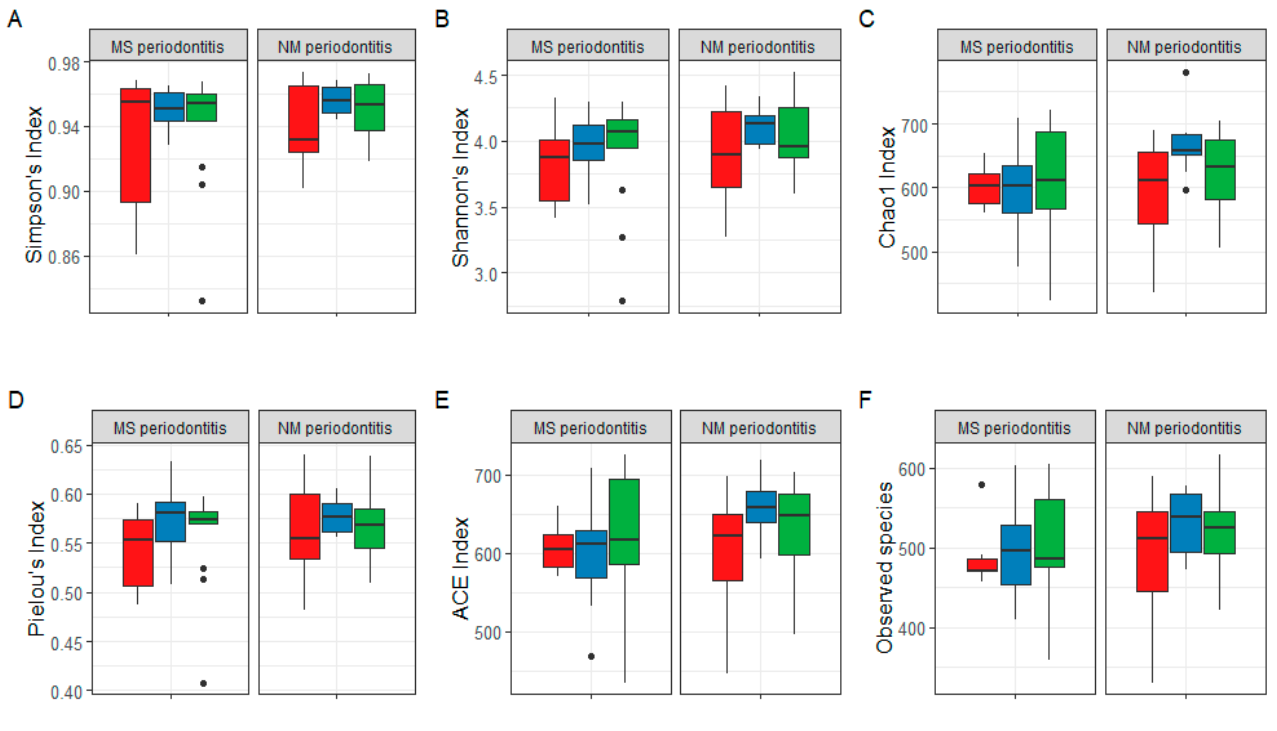
Figure 9. Alpha diversity in 75 subgingival plaque samples grouped based on periodontal health status and BMI. Shannon’s index ( A ), Simpson’s index ( B ), Chao1 index ( C ), Pielou’s index ( D ), ACE ( E ), and observed species ( F ). Box plots show Q1-median-Q3 with data range. Black dots are outlier values. MS: moderate-severe periodontitis, NM: no-mild periodontitis .